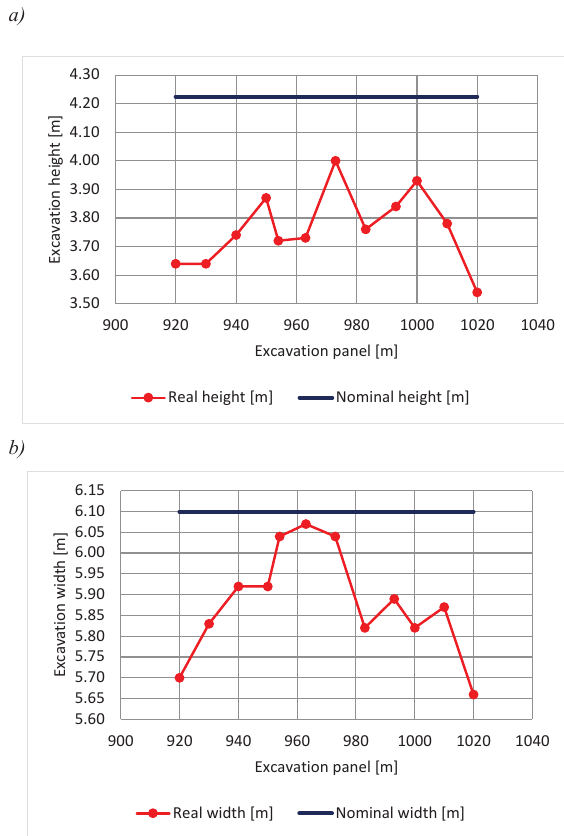
Fig. 5. Change of height (a) and width (b) of yielding support arches in relation to nominal dimensions in the panel of airway crosscut W-1